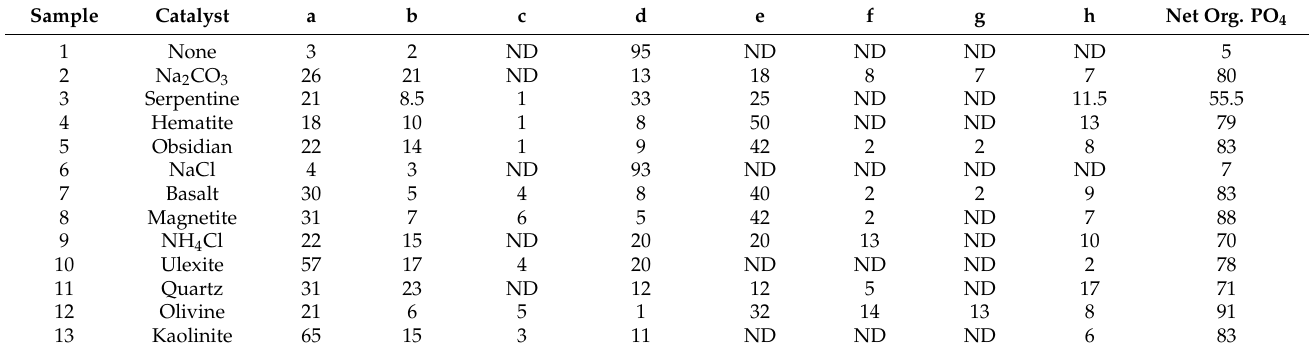
Table 1. Yields 1 (%) of various phosphates species detected in the phosphorylation of glycerol.